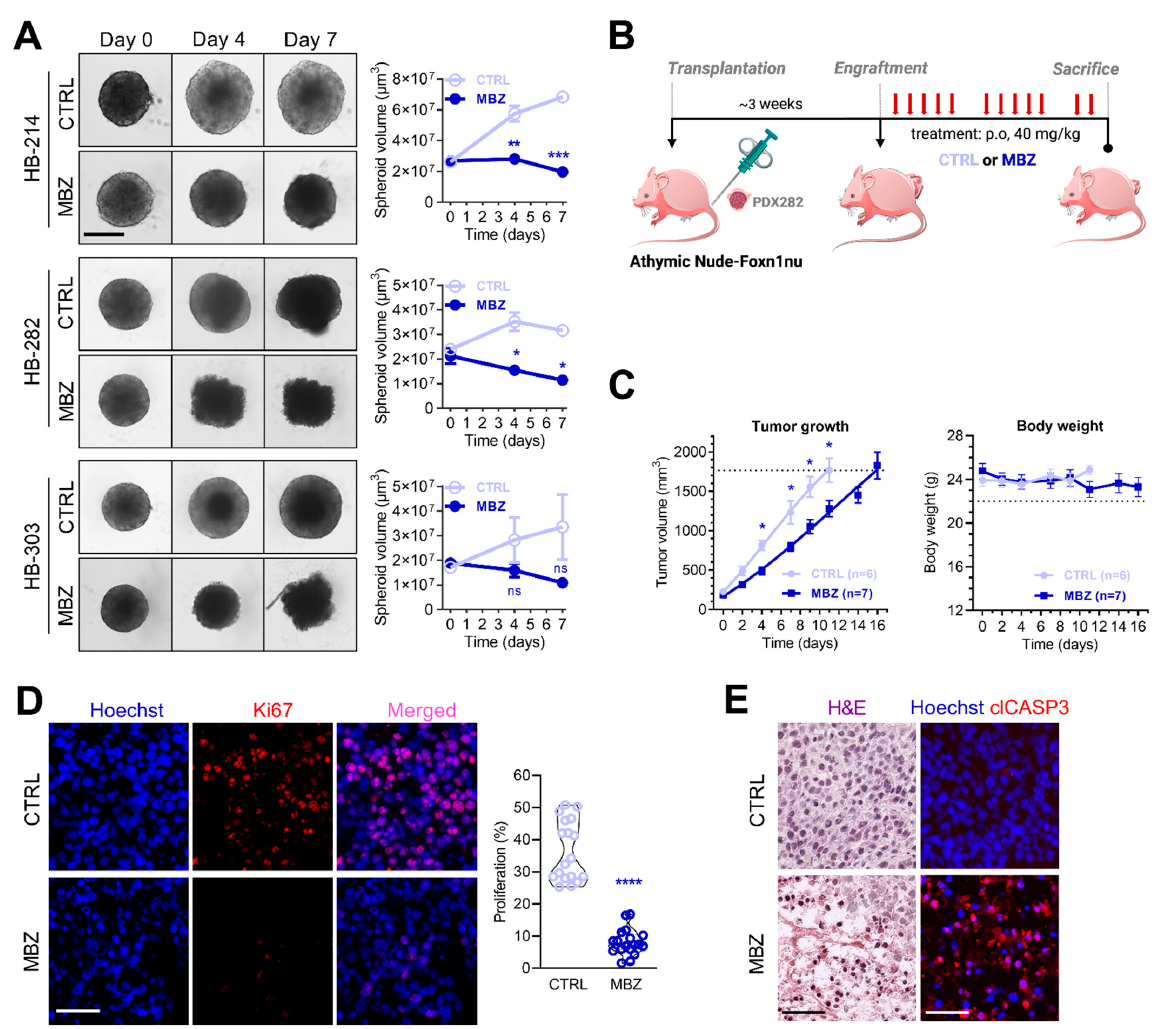
Figure 4. Mebendazole testing in patient-near spheroid and xenograft models. ( A ) Established tumor spheroids of HB-214, HB-282, and HB-303 cells were treated with vehicle (CTRL) or mebendazole (MBZ) at concentrations of 2 µ M, 4 µ M, and 2 µ M for 0, 4, and 7 days. The graph represents mean spheroid volumes of one experiment consisting of triplicate measurements. Scale bars represent 300 µ m, error bars represent ± SD. p -values were calculated using a two-tailed unpaired Student’s t test. ( B ) Experimental overview of mebendazole testing in vivo. Immunocompromised mice bearing subcutaneously transplanted HB-282 tumors were treated with 40 mg/kg body weight mebendazole (MBZ) by oral administration or vehicle (CTRL) 5 times per week. Mice were sacrificed on the day that they reached the maximal tolerable tumor size of 1,764 mm 3 . ( C ) Tumor growth (left panel) and body weight changes (right panel) in mice treated with either MBZ (n = 7) or vehicle (n = 6). Values correspond to mean tumor volumes and mean body weights ± SEM. Dashed lines indicate maximum permissible values. ( D ) Immunofluorescent staining of Ki67 positive nuclei (red) counterstained with Hoechst 33342 (blue) of vehicle (CTRL) and mebendazole (MBZ) treated tumors. Scale bars represent 50 µ m. Proliferation was calculated by relating Ki67 positive nuclei of six representative areas of three tumors per condition to Hoechst 33342 nuclei. ( E ) Hematoxylin/eosin (H&E) staining of vehicle (CTRL) and mebendazole (MBZ)-treated tumors ( left panel) and immunofluorescent staining of cleaved caspase-3 (clCASP3; red) indicating apoptotic regions counterstained with Hoechst 33342 ( right panel). Scale bars represent 50 µ m. Significance is given as follows: ns, not significant; * p < 0.05; ** p < 0.01; *** p < 0.001; **** p <